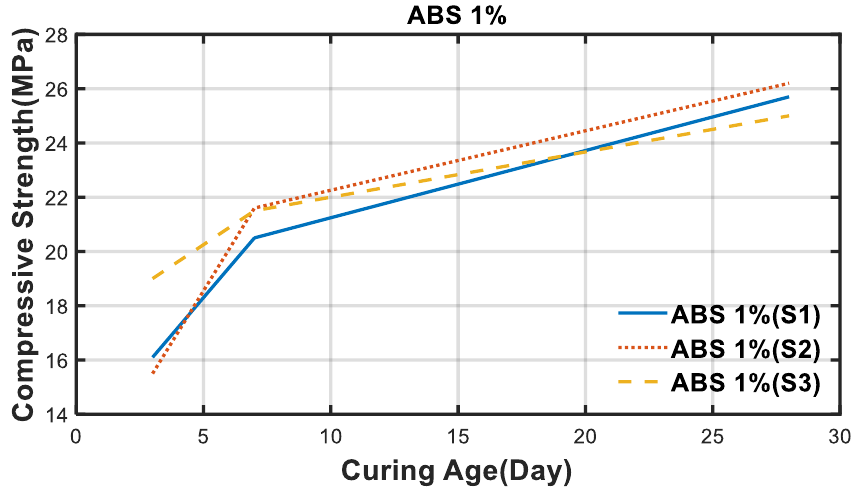
Figure 6. Graph of strength measurement results between ABS (1%) specimens.